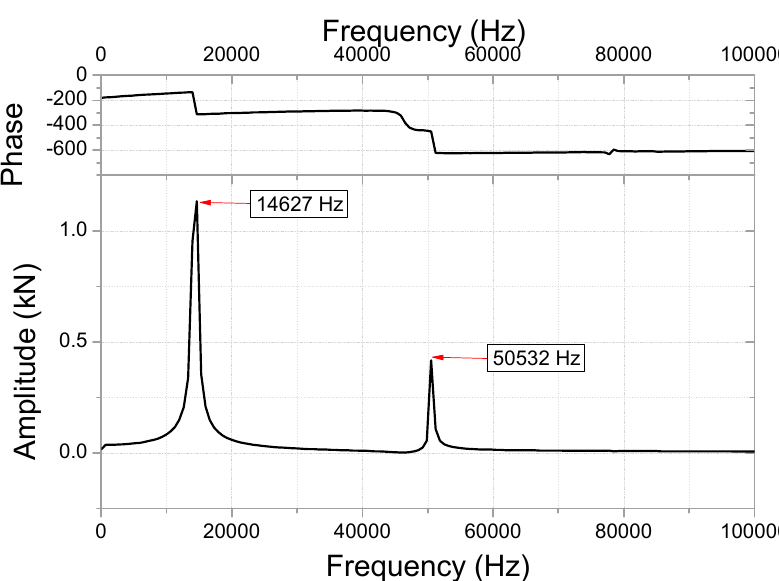
Figure 6. Fast Fourier transform (FFT) for residual force vibration (undamped area shown in Figure 5) in the frequency domain.